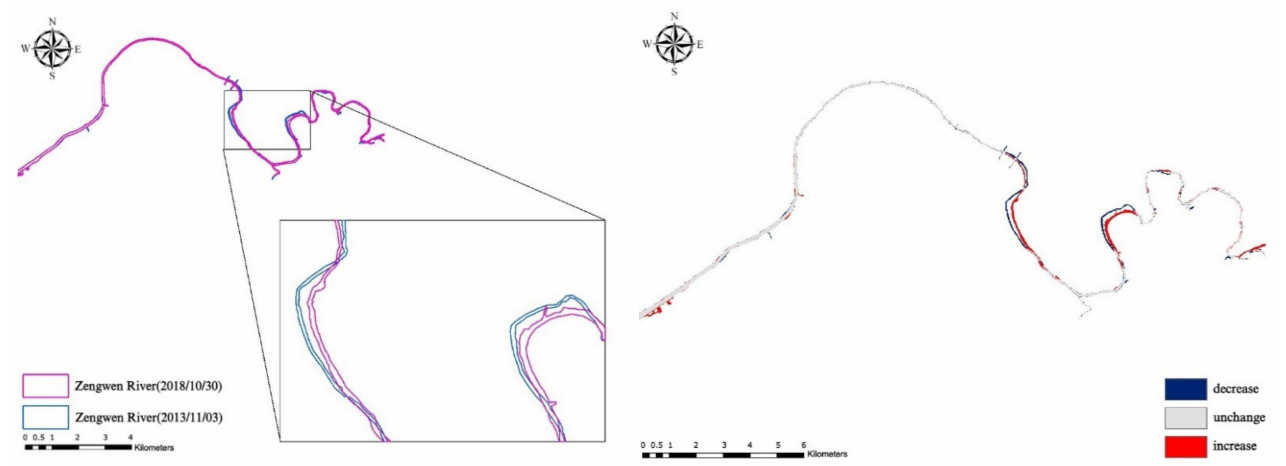
Figure 11. The Zengwen River changes between two epochs. The Qishan River is located in an upstream area with mostly mountainous terrain and only a few artificial buildings; the NDWI and I and mathematic morphology exhibited the best performance for the Qishan River. The difference between the two epochs is demonstrated by the changes in the river channel (Figure 12).